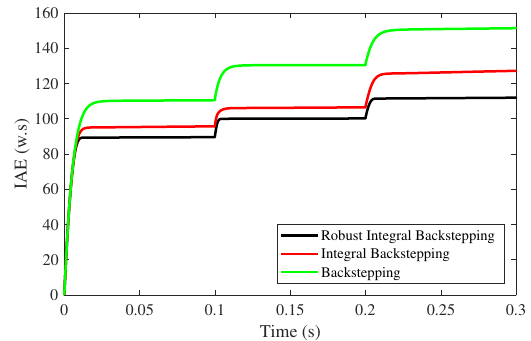
Figure 12. IAE for varying temperature and irradiance.